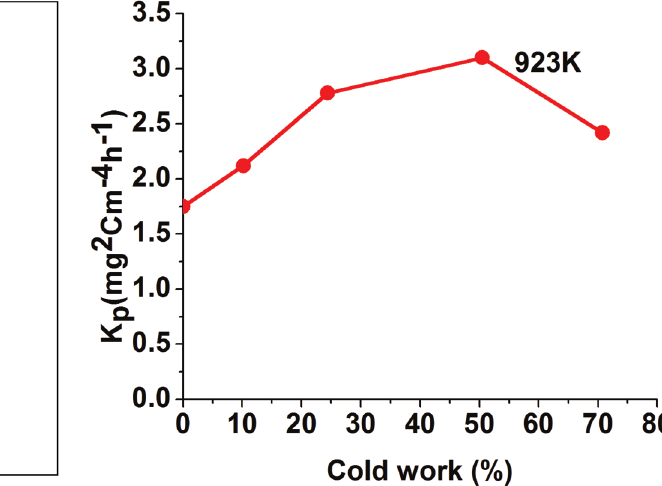
Fig. 2: Schematic diagram of experimental set up for corrosion study